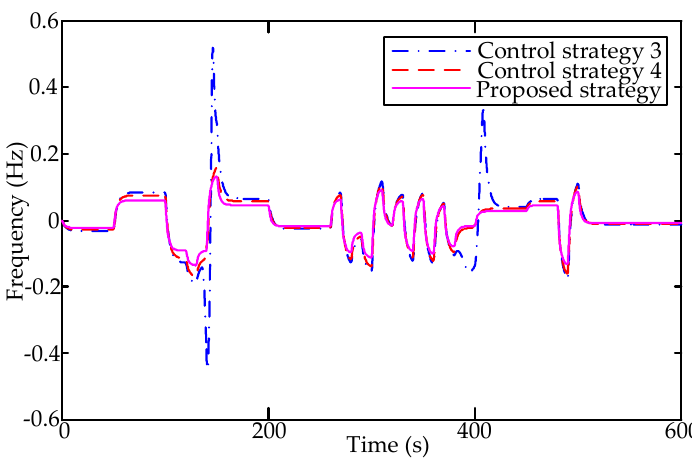
Figure 13. The frequency response under different control schemes.